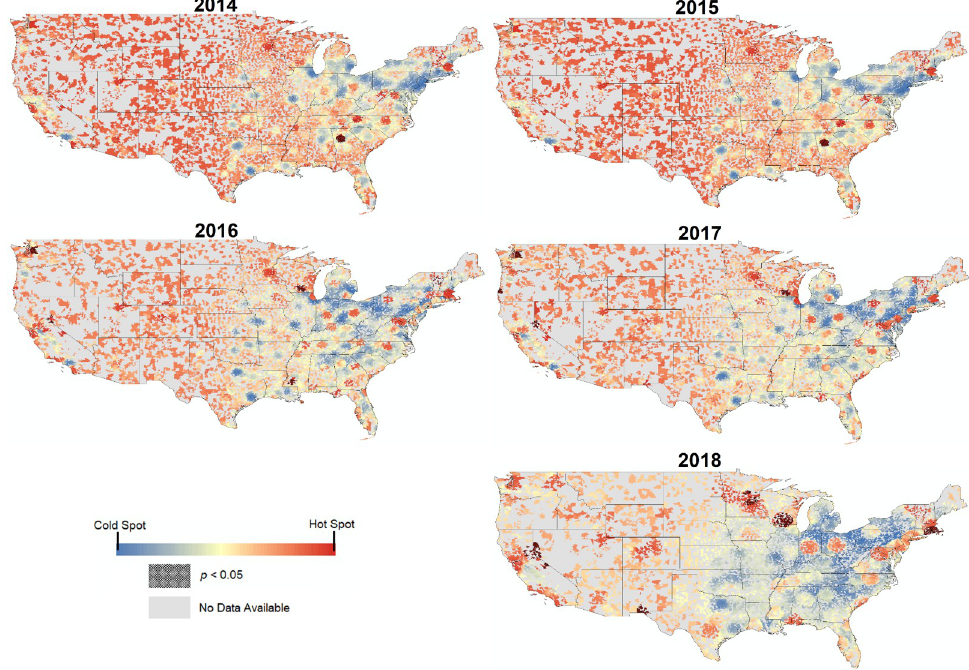
Fig 2. In blue-red gradient, annual variation in geospatial clustering of average individual payments per zip code, with hatched overlay representing statistical significance. Cartographic boundaries obtained from the U.S. Census Bureau and reprinted with permission in accordance with OMB Memorandum M-10-06 and Executive Order